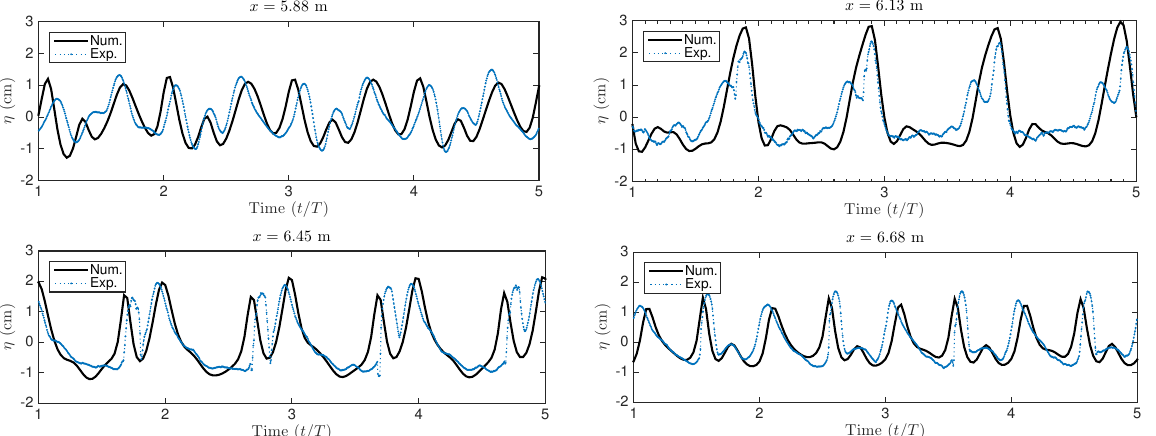
Figure 8. Experimental and numerical results of the water elevation for Test A using Mesh 2 ( ∆ x = 2.5 cm and ∆ z = 0.2 cm).